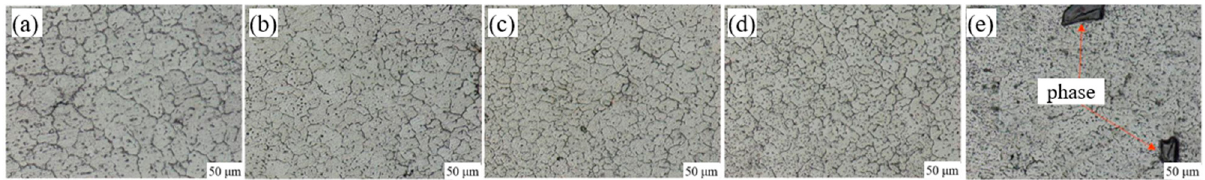
Figure 4. Microstructure of B 4 C particle with different deposition rates. ( a ) 120 mm/min, ( b ) 130 mm/min, ( c ) 140 mm/min, ( d ) 150 mm/min, ( e ) 140 mm/min-B 4 C.